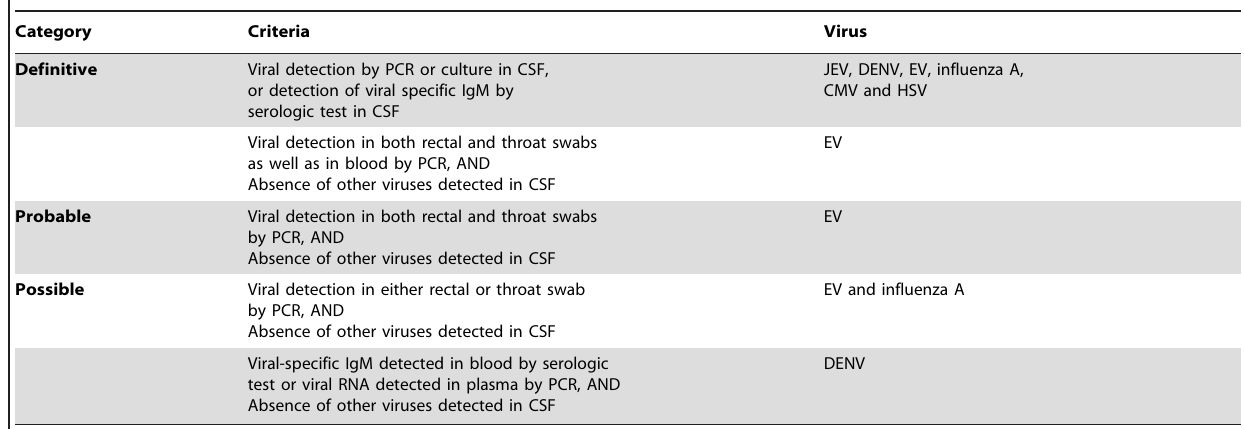
Table 2. Diagnostic interpretation.